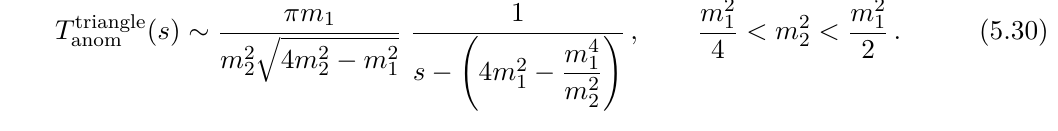
( s ) for m 2 = 2 / 3 2 CFT